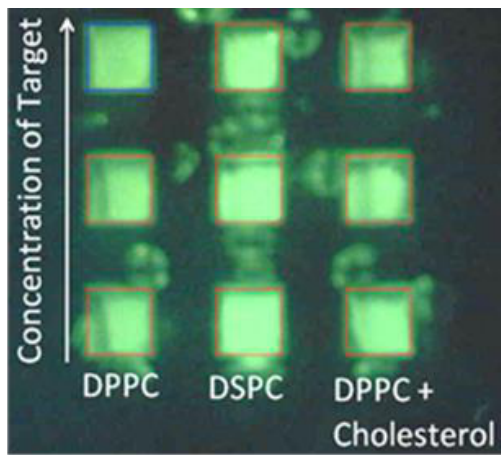
Figure 1. A cross-sectional view of microwells of array sensor with illustration of the fluorescence photometric system. Polydimethylsiloxane (PDMS); Light-Emitting Diode (LED).